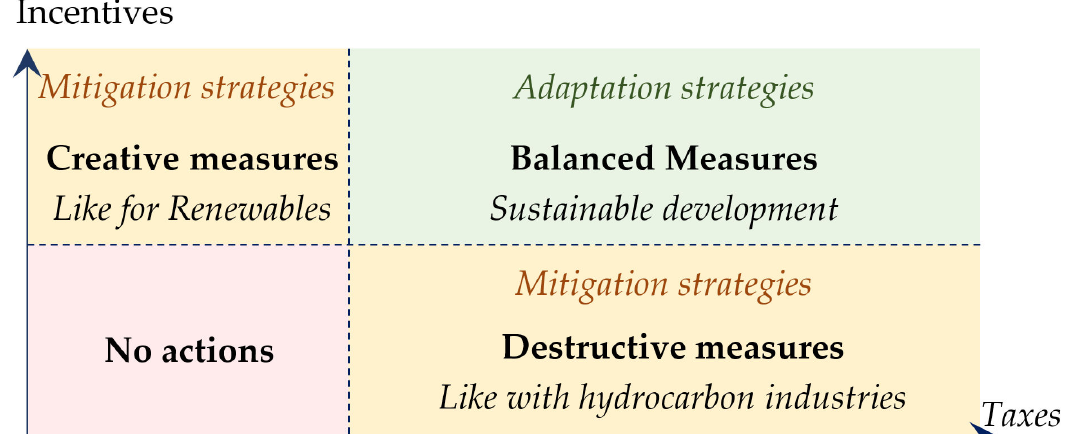
Figure 6. Essence of climate policy